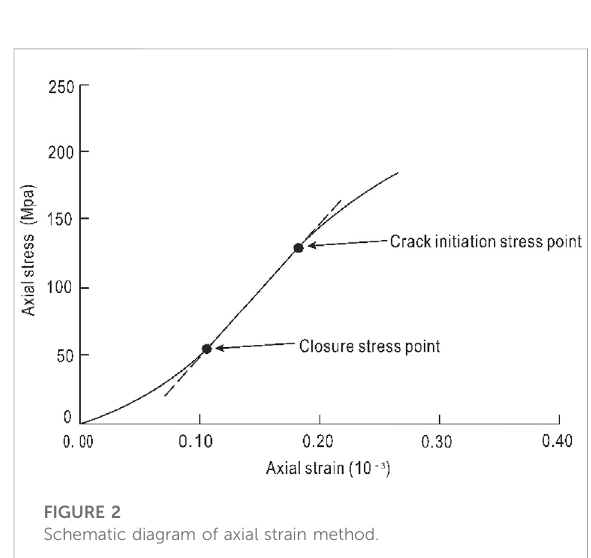
FIGURE 2 Schematic diagram of axial strain